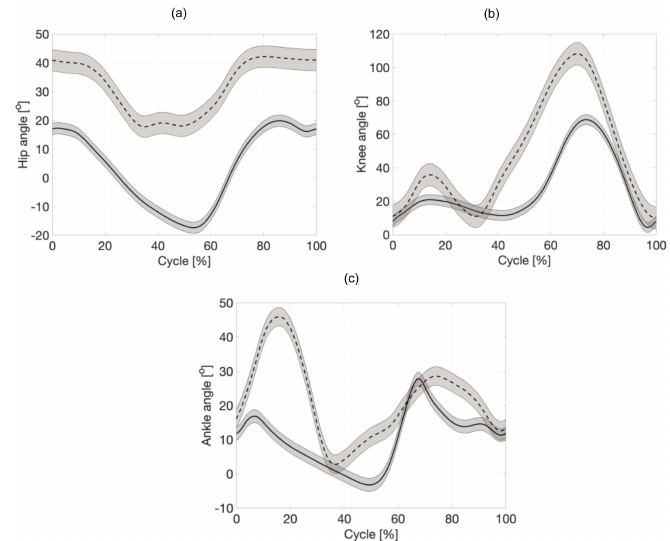
Figure 4. Anteroposterior joint angles during preferred walking (—) and running (---). The percentage of the gait cycle is shown on the x -axis. ( a ) hip, ( b ) knee, and ( c ) ankle.